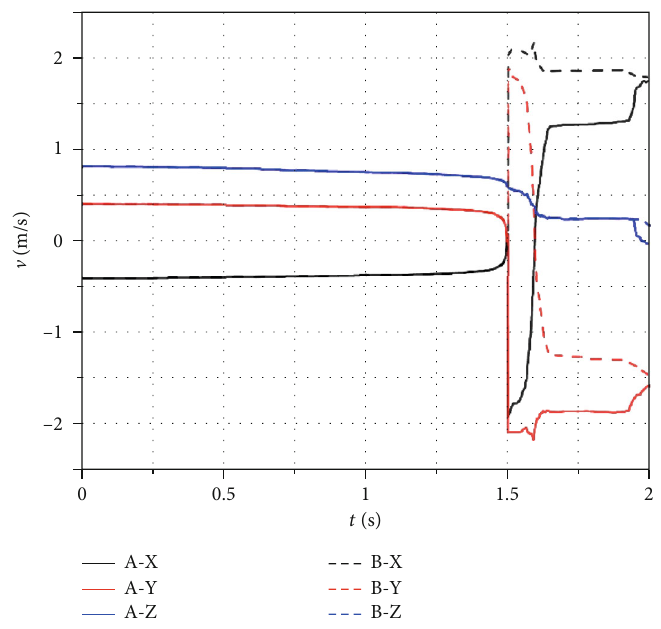
Figure 12: X , Y , and Z velocities of split masses A and B of closing mechanism 1.